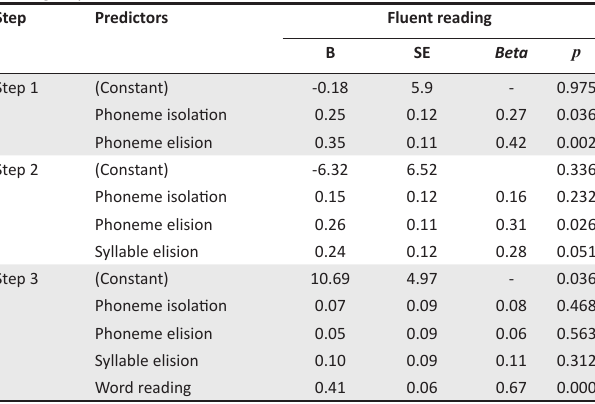
TABLE 4: Summary of multiple regression with fluent reading as dependent variable and phoneme isolation , phoneme elision, syllable elision and word reading as